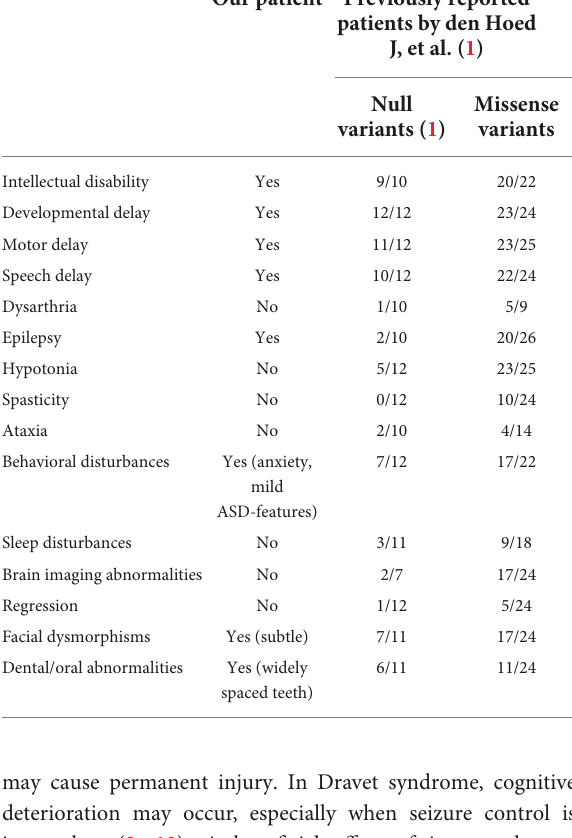
TABLE 1 Neurological clinical features of patients with SATB1 gene